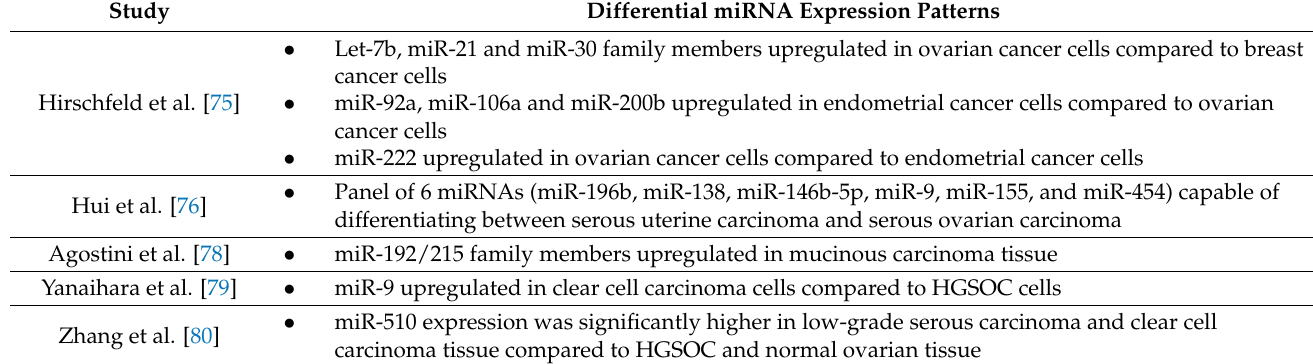
Table 4. Variation in miRNA expression between (i) ovarian cancer and other female cancers and (ii) ovarian cancer subtypes. Differential miRNA Expression